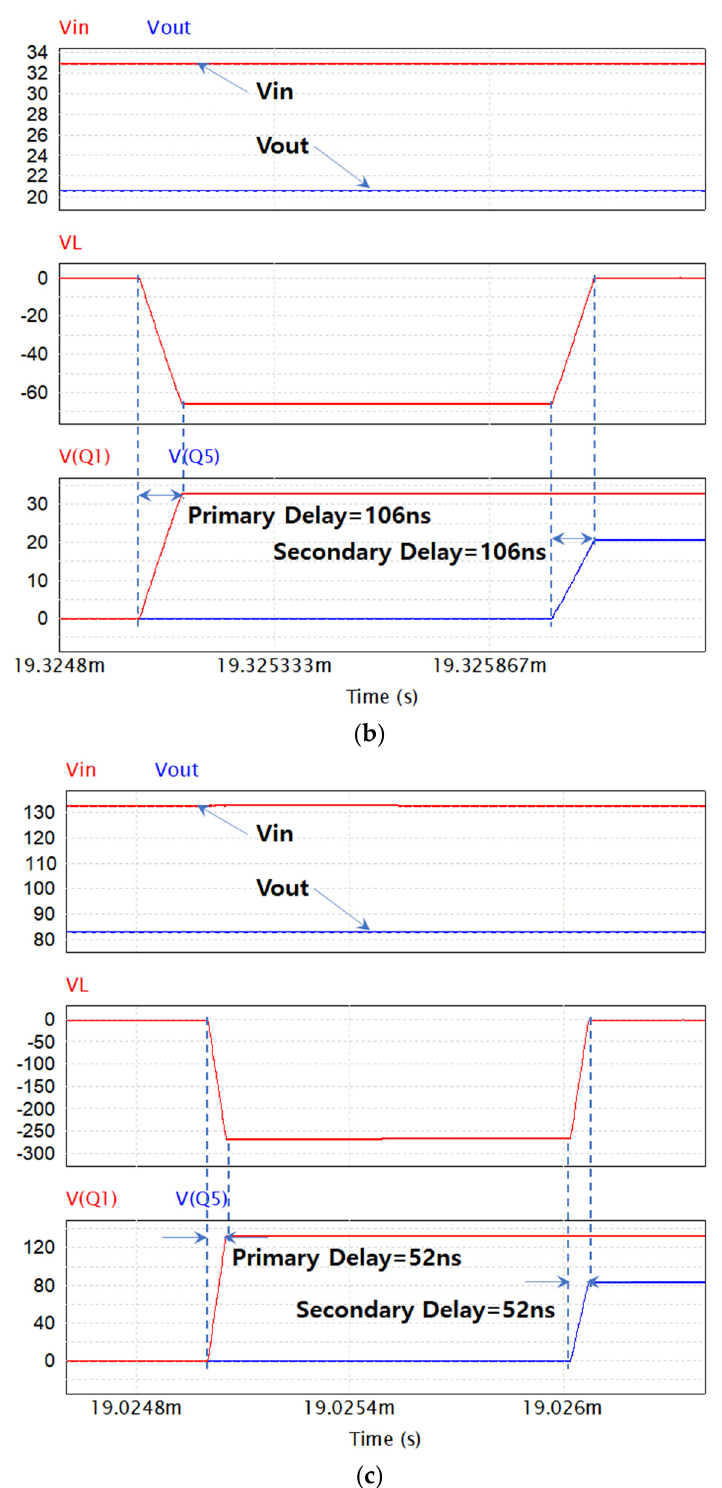
Figure 11. Voltage characteristics of the DAB converter with optimal parasitic capacitance: ( a ) input voltage 13 V; ( b ) input voltage 33 V; ( c ) input voltage 133 V.